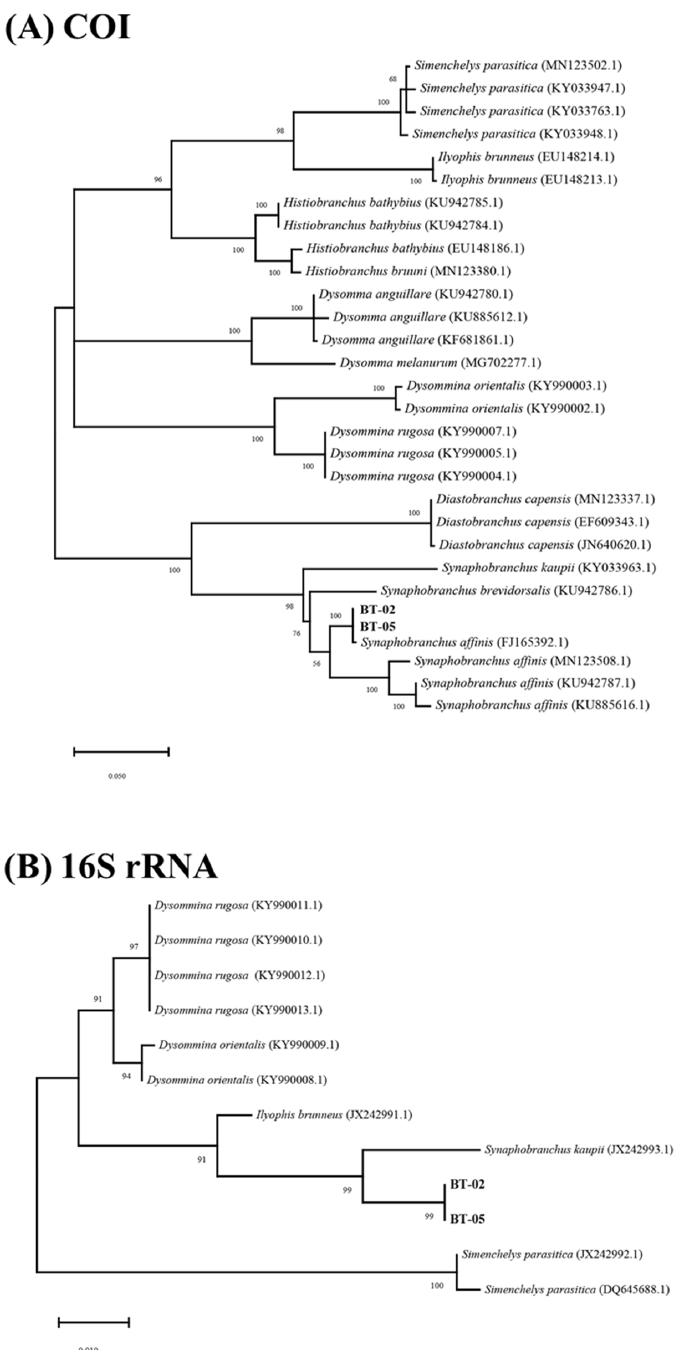
Figure 4. Phylogenic tree based on ( A ) mitochondrial CO1 and ( B ) 16S rRNA gene sequences using RAxML ‐ NG in raxmlGUI 2.0 software.